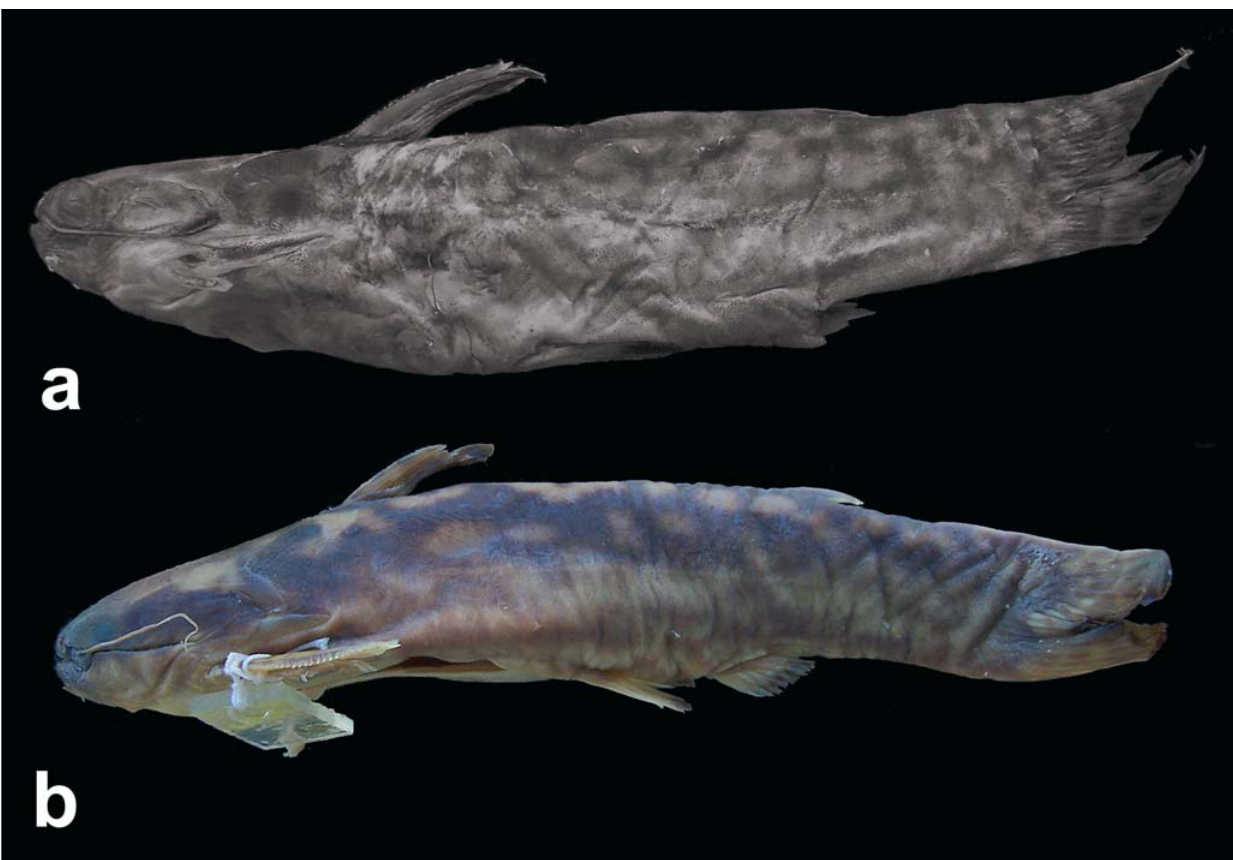
Fig. 7. Tatia aulopygia , (a) INPA 11080, male, 104.6 mm SL, Guaporé river, Amazonas State, Brazil. (b) ZMA 114.280, young female, 46.3 mm SL, Humaitá, Amazonas State,